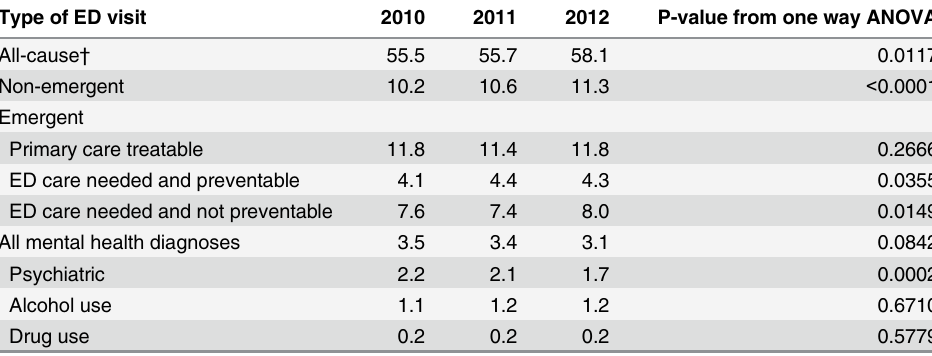
Table 1. Number of Emergency Department Visits Per 100 Primary Care Patients by Year and Type, N = 71,296.